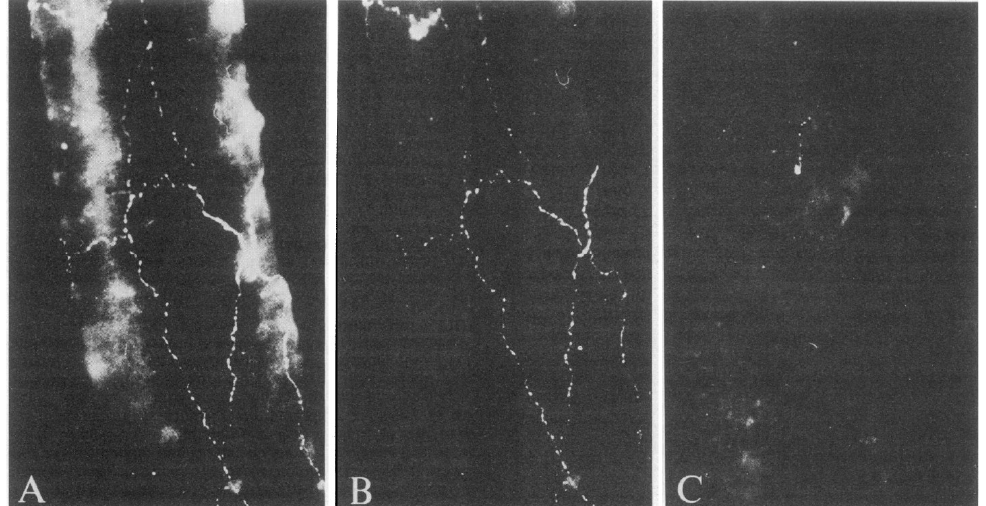
Figure 2. The immunoreactivity of calcitonin gene-related peptide (CGRP) around cerebral blood vessels. ( A ) Network of CGRP immunofluorescence in fibres innervating the cerebral arterioles. ( B ) Colocalization with substance P (SP). ( C ) Almost complete absence of CGRP immunofluorescence in cerebral arterioles after ipsilateral trigeminal nerve surgical lesion 14 days before sacrifice (adapted with permission from [45]).